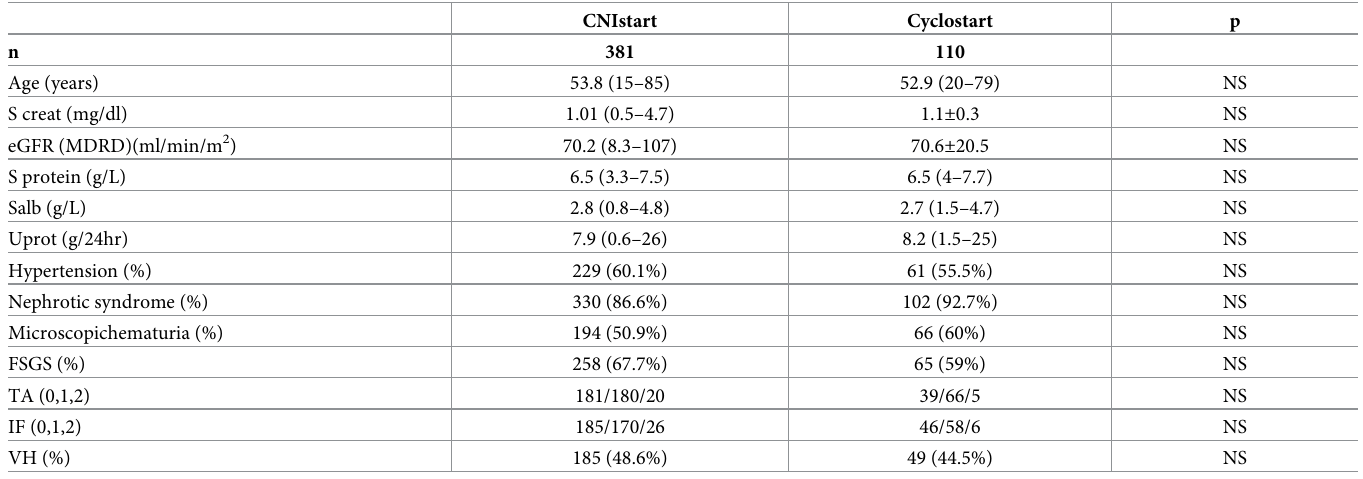
Table 3. Clinical and histological differences between patients receiving CNIs or Cyclo as first line immunosuppression (CNIstart and Cyclostart, respectively).